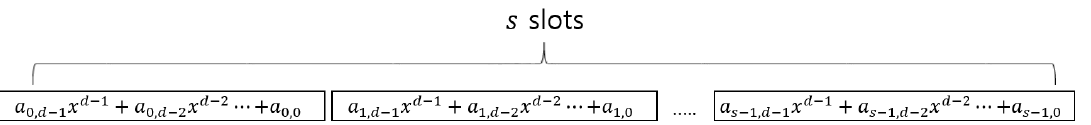
Figure 4. The structure of a